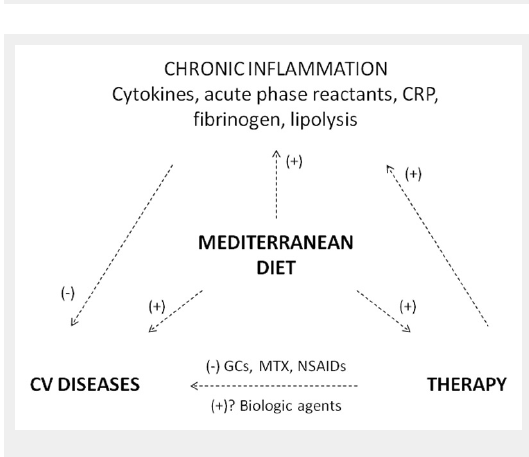
The relationship between chronic inflammation, the development of cardiovascular diseases, pharmacological therapy and the Mediterranean diet. Cardiovascular diseases and, in particular, accelerated atherosclerosis, are comorbidities that are frequently observed in patients suffering from rheumatic conditions. They are caused not only by sustained inflammation, but also by the chronic use of pharmacological therapy. A healthy diet such as the Mediterranean one, with its anti-inflammatory and anti-oxidant components, could have beneficial effects by acting simultaneously on inflammation, the cardiovascular system and treatment. CRP = C-reactive protein; CV = cardiovascular; GCs = glucocoticoids; MD = Mediterranean diet; MTX = methotrexate; NSAlDs = nonsteroidal antinflammatory drugs; (+) positive effect, (-) negative